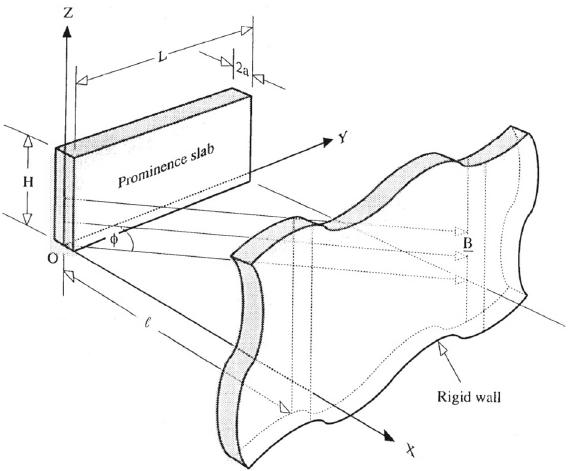
Fig. 39 Schematic diagram of a prominence slab in a coronal environment. The magnetic field makes an angle φ with the prominence axis and is tied at the photosphere, represented by two rigid, perfectly conducting walls. Image reproduced with permission from Joarder and Roberts (1993b), copyright by